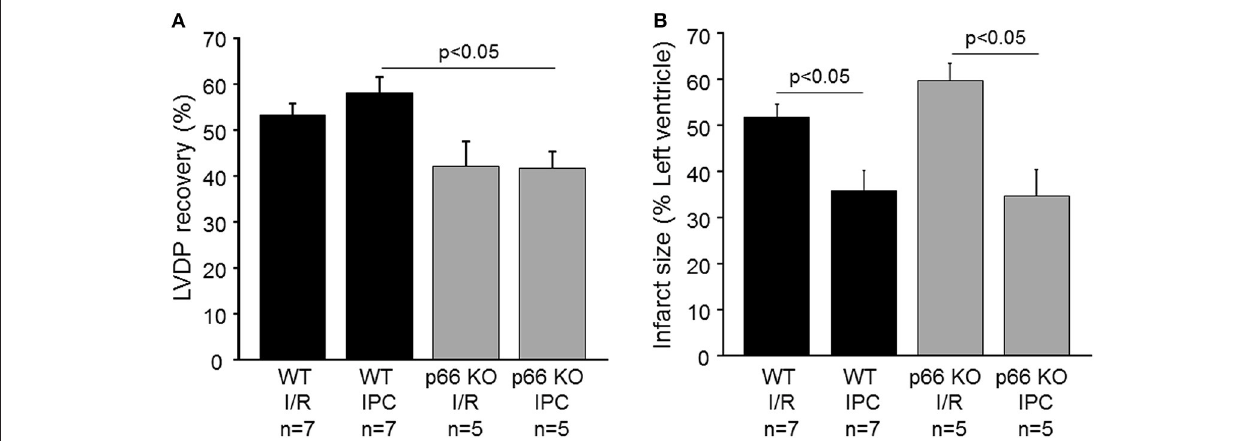
FIGURE 3 | Influence of p66shc on myocardial function, IR injury and cardioprotection in vitro . (A) Left ventricular developed pressure (LVDP) at the end of reperfusion in % of that at the end of the stabilization period in wildtype (WT) and p66shc knockout (p66 KO) mice undergoing ischemia/reperfusion (IR) or ischemic preconditioning (IPC). (B) Infarct size (in % of left ventricle) in WT and p66shc-KO mice subjected to IR or IPC.